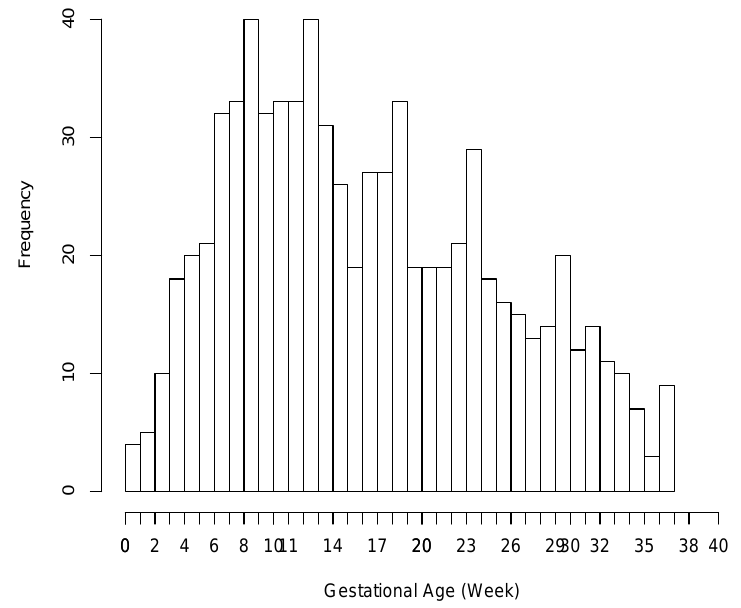
Figure 3. Vaccination time in gestational age from the pH1N1 vaccine